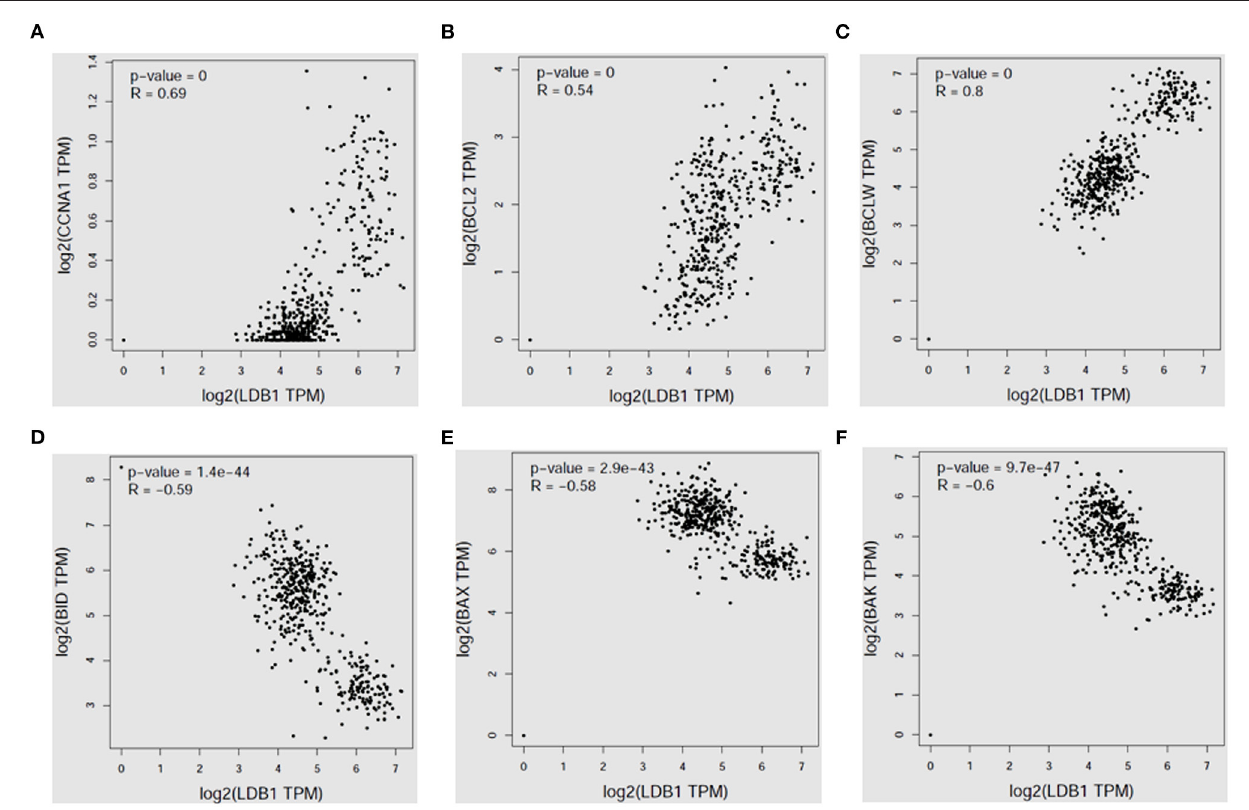
FIGURE 2 | LDB1 expression is positively correlated with survival signals in colorectal cancer. The correlation analysis between LDB1 expression and CCNA1 (A) , BCL2 (B) , BCLW (C) , BID (D) , BAX (E) or BAK (F) in colon adenocarcinoma was analyzed by GEPIA database.